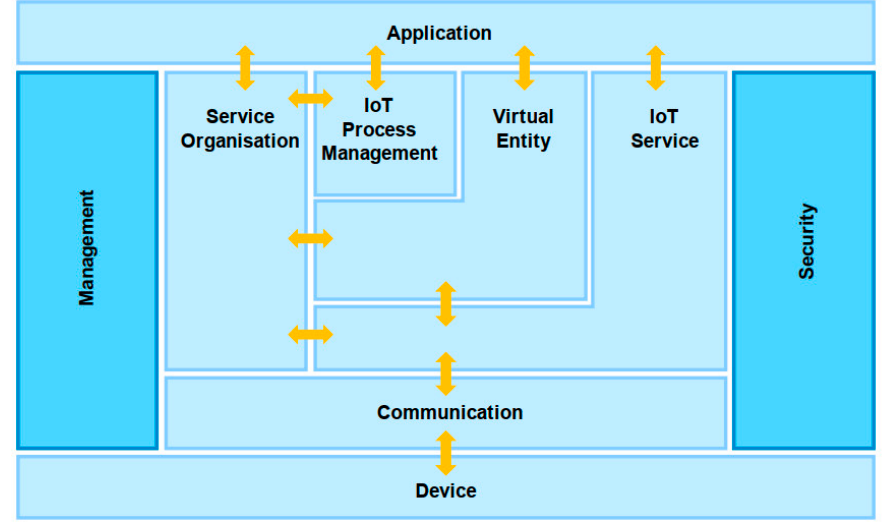
Figure 4. IoT-A IoT framework [21].